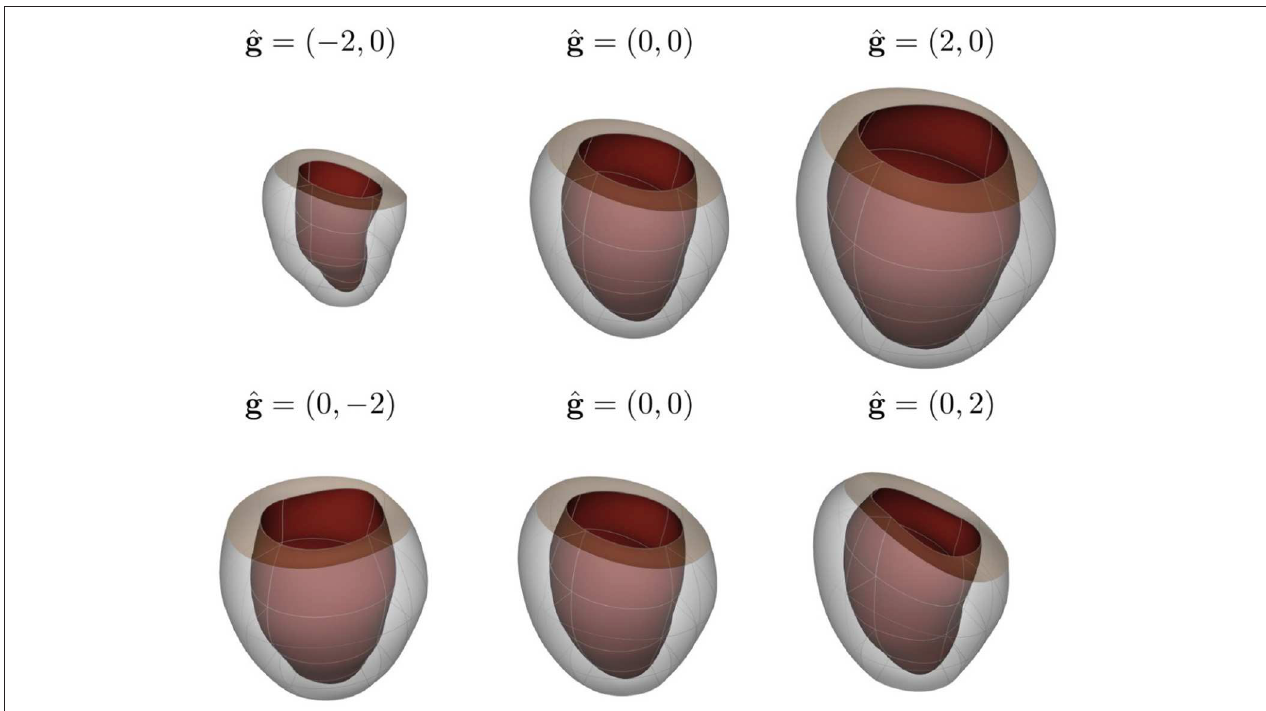
FIGURE 5 | Visualization of LV shape related to the first two principal components of shape variation seen across the population of individuals considered in this study (first and second rows correspond to g 1 and g 2 , respectively). The mean shape is shown in the central column, while the weights corresponding to g j deviations ( 2, j 1,2) are shown together with the mean shape for each principal component in the left and right columns, ˆ = ± =